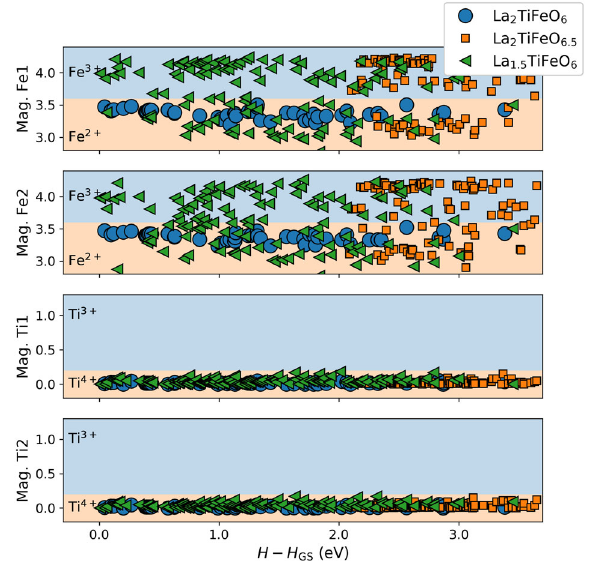
Fig. 5 Magnetic moment distributions from AIRSS results includ- ing the La-poor and O-rich phases. The distribution for stoichio- metric La 2 TiFeO 6 is rather homogeneous across the whole spectrum, with the CT Fe 2 + (HS)/Ti 4 + CT state as the most likely state. A higher percentage of oxidized Fe 3 + emerges when defects are included. Ti1, Ti2, Fe1, and Fe2 refer to the different Ti and Fe positions in the unit